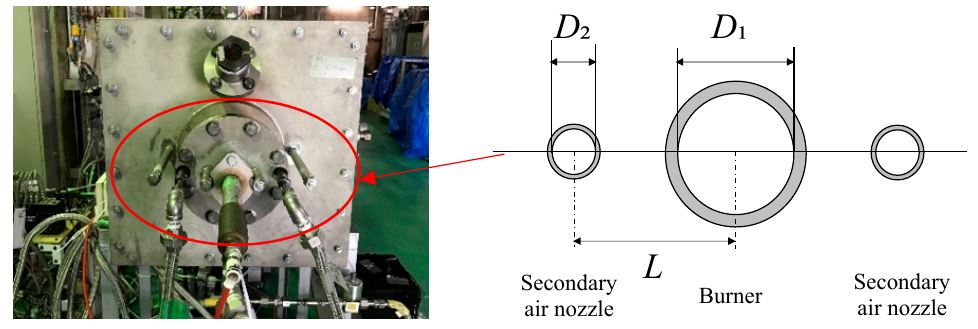
Figure 2. The burner mounting plate.